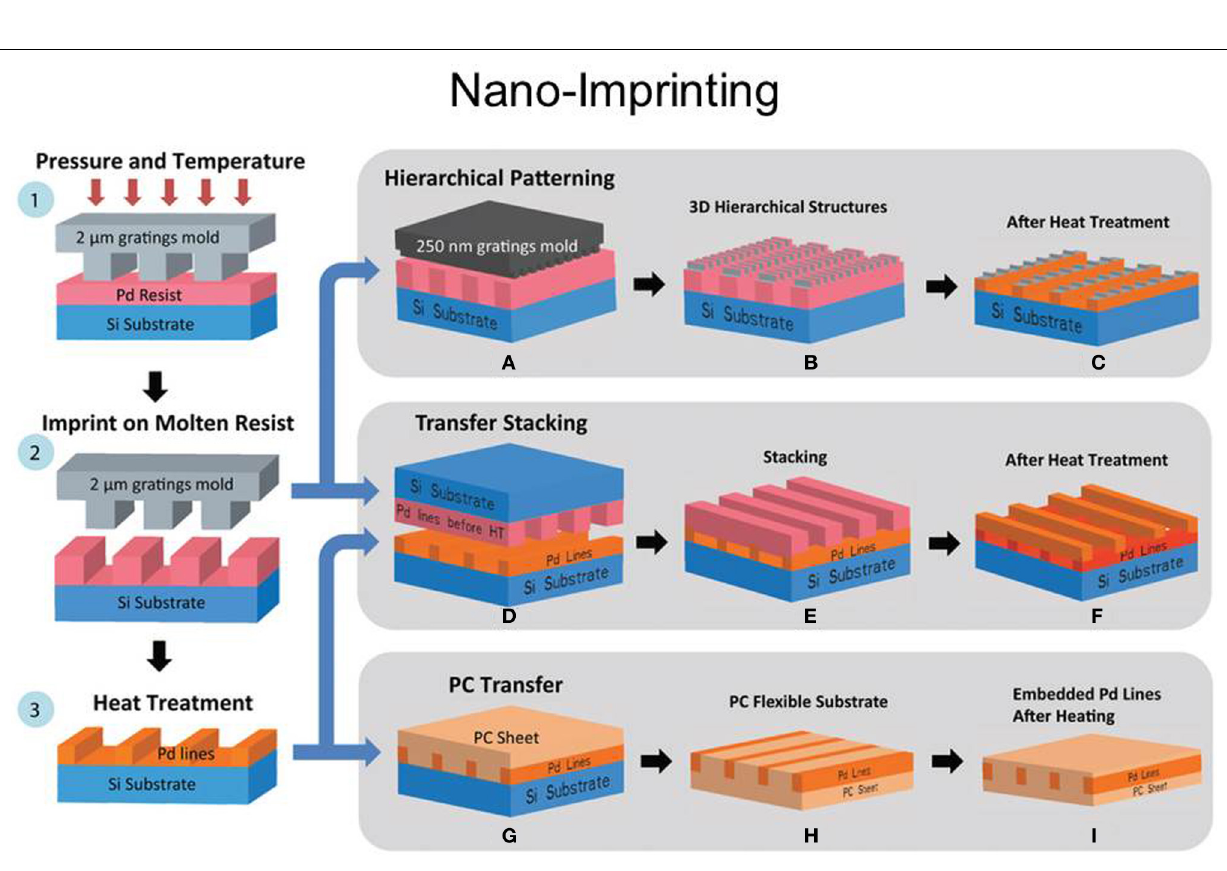
possibilities: (A–C) hierarchical patterning can be obtained by using a different Si mold with smaller feature sizes on top of the imprinted Pd benzylthiolate patterns; (D–F) transfer stacking that is realized by using the Pd pattern and (3) as a substrate; (G–I) polycarbonate (PC) transfer that is obtained by using (3) as mold and PC as substrate. (Reprinted by permission from Macmillan Publishers Ltd: Radha et al.,